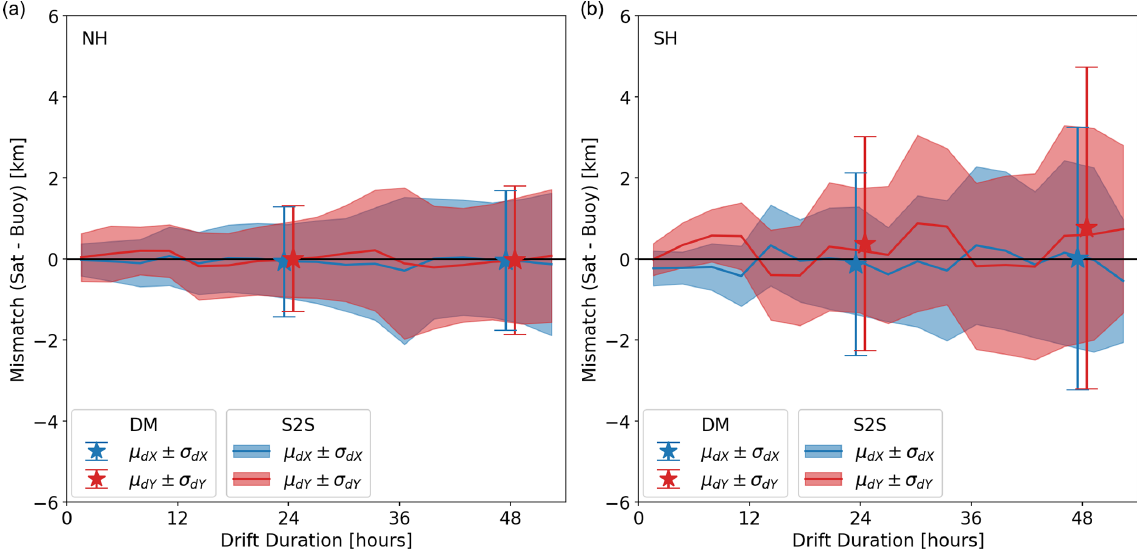
Figure 5. Evolution of the validation statistics of the S2S and DM drift vectors with drift duration in the NH (a) and SH (b) . For S2S drift vectors, bias (solid lines) and RMSE (shaded regions) are plotted for the range from ∼ 100min to 52h. Symbols (bias: star; RMSE: error bar) are shown for DM drift vectors with 24 and 48h drift duration.